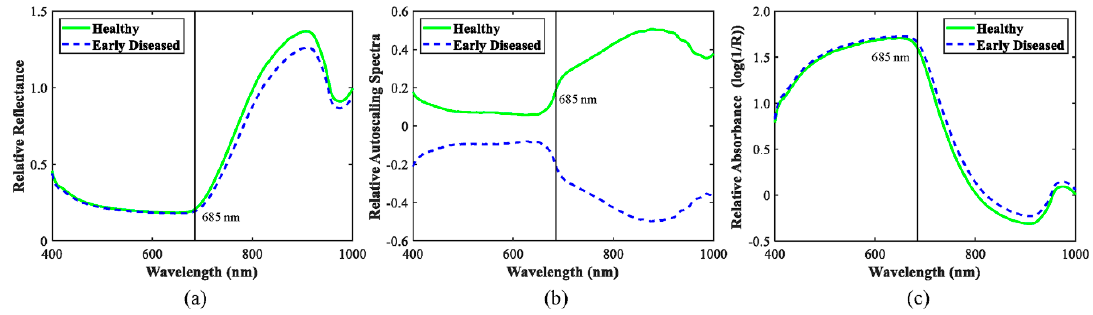
Figure 5. The mean relative reflectance ( a ), autoscaling ( b ), and absorbance spectra ( c ) for healthy and early disease blueberries.